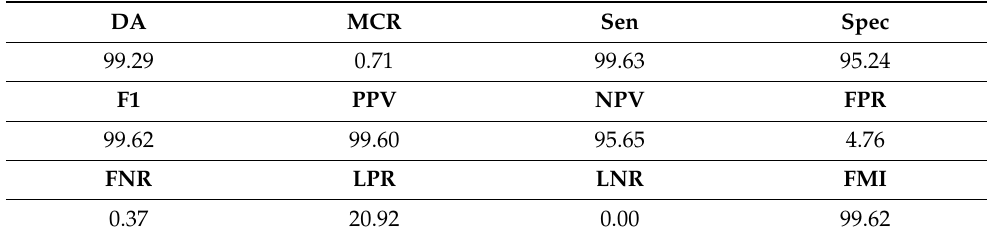
Table 6. Performance Analysis of KNN (%) During Training